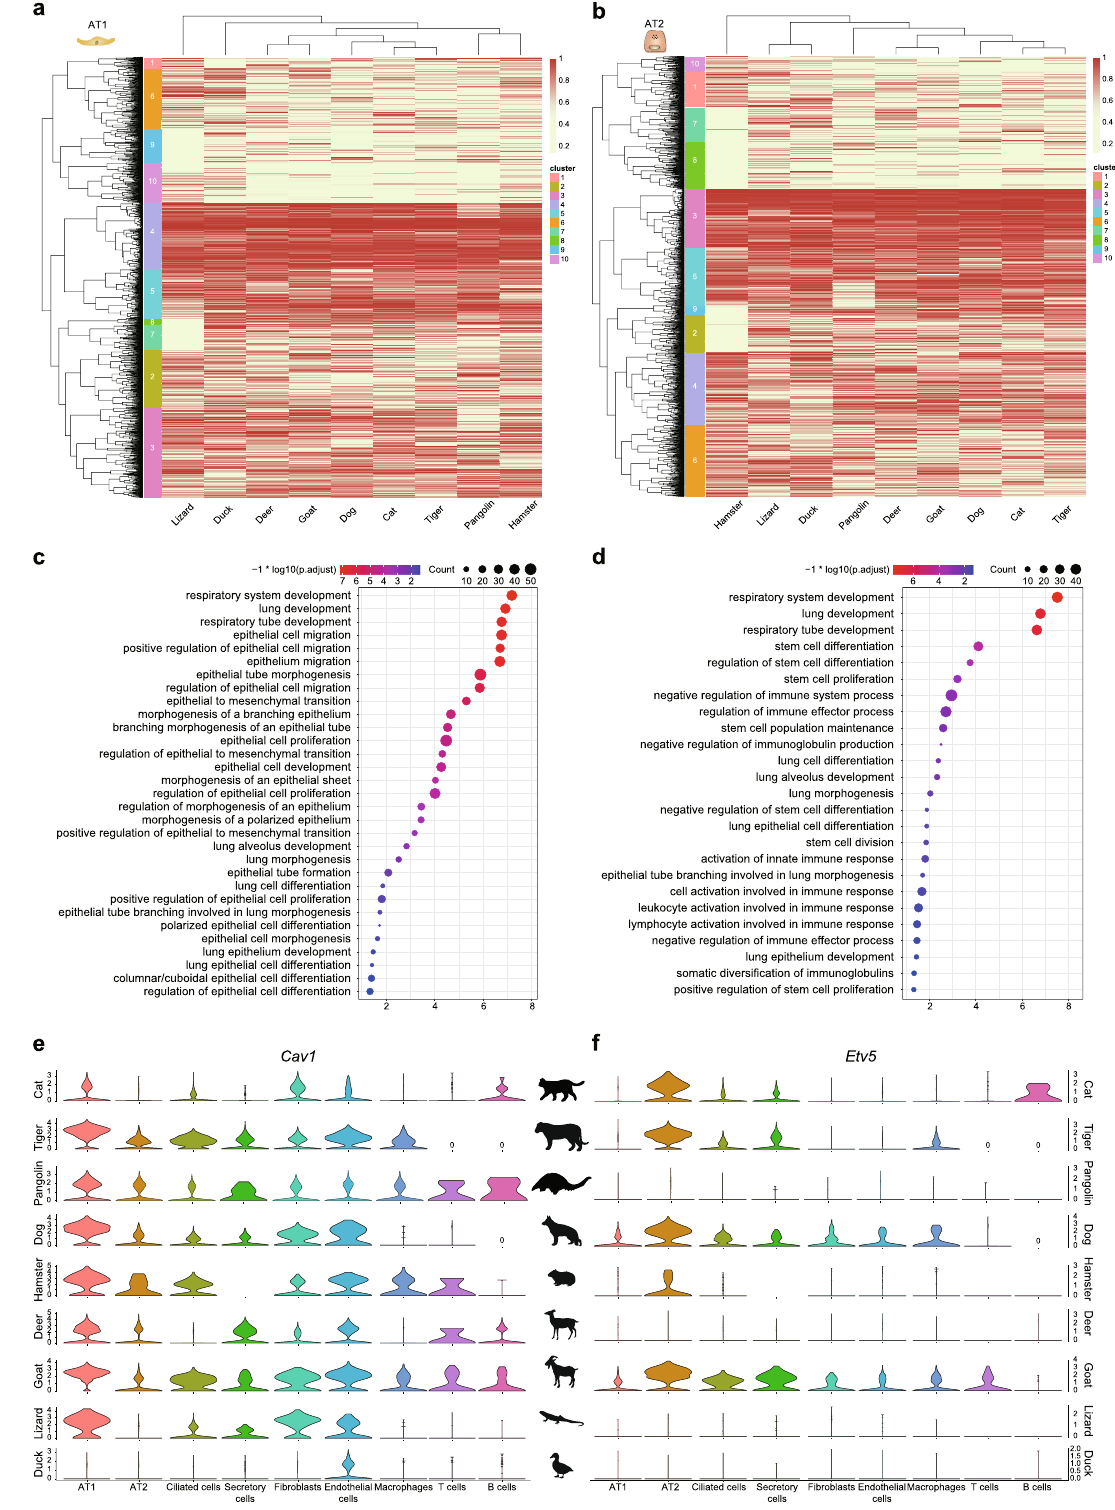
Fig. 7 Conserved core expression programs in AT1 and AT2 cells. a , b Heatmap showing clustering of orthologs in AT1 ( a ) and AT2 cells ( b ) across different species, with cluster index displayed on left. Each row represents one ortholog and each column represents one species. Colors represent expression levels of orthologs. c , d GO terms enriched in AT1 and AT2 cell-conserved orthologs. e , f Violin plot showing cell type-speci fi c expression patterns of AT1 cell-conserved gene ( Cav1 ) and AT2 cell-conserved gene ( Etv5 ). P -values were calculated using hypergeometric test. Multiple comparisons adjustment was performed using Benjamini and Hochberg method. Exact P -value and source data were included in the Source Data fi